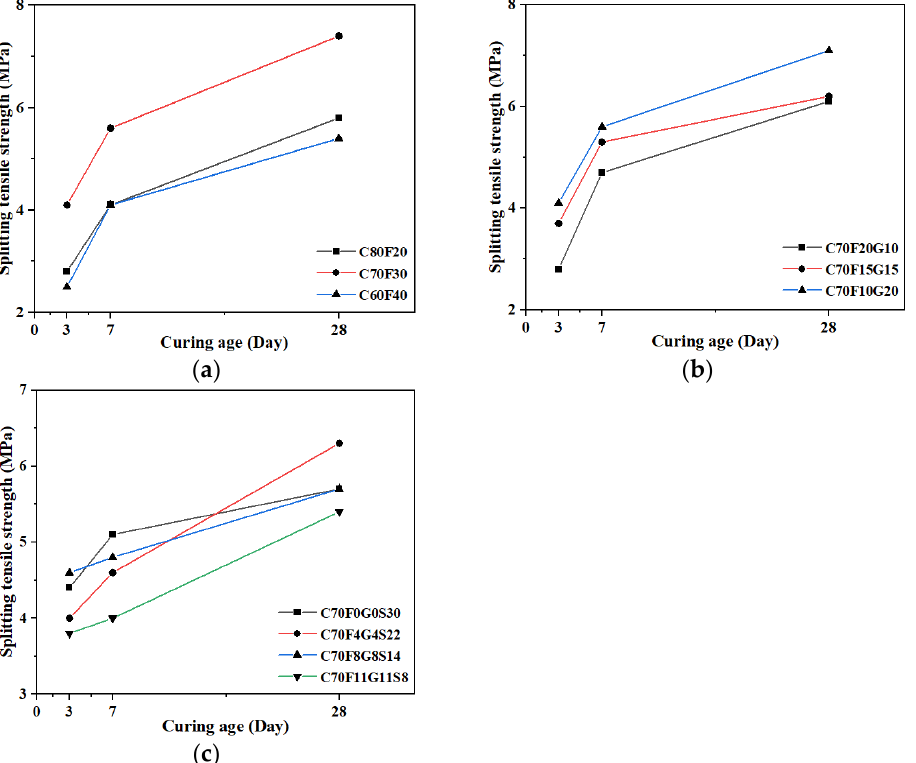
Figure 9. Splitting tensile strength of concrete. ( a ) Group FA Splitting tensile strength; ( b ) Group GGBS Splitting tensile strength; ( c ) Group SSP Splitting tensile